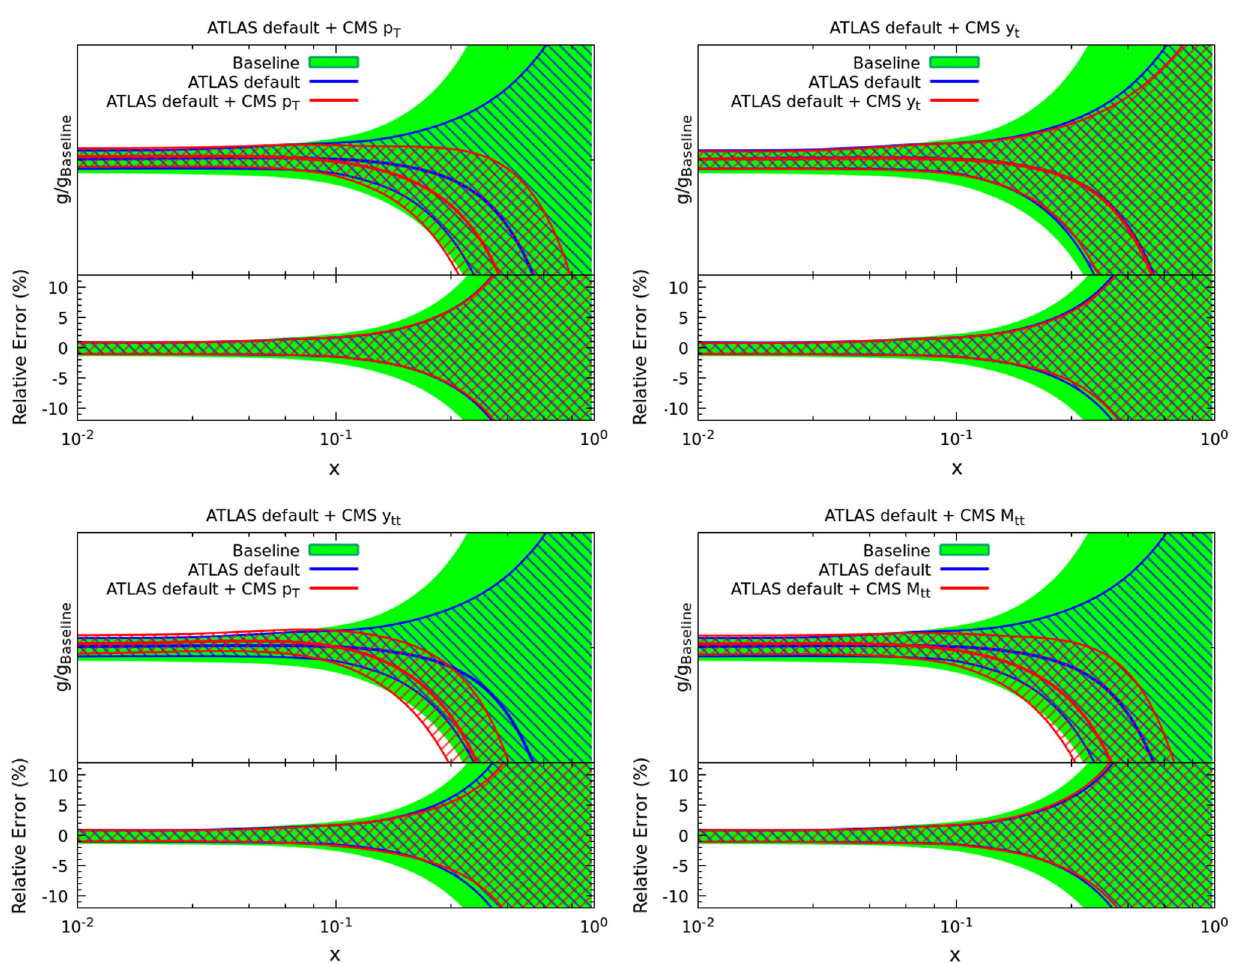
Fig. 12 Impact of combining the default ATLAS combination of p T and M tt distributions with the parton shower error decorrelated from the lepton + jets channel and the y tt distribution from the dilepton with the CMS rapidity distributions on the gluon